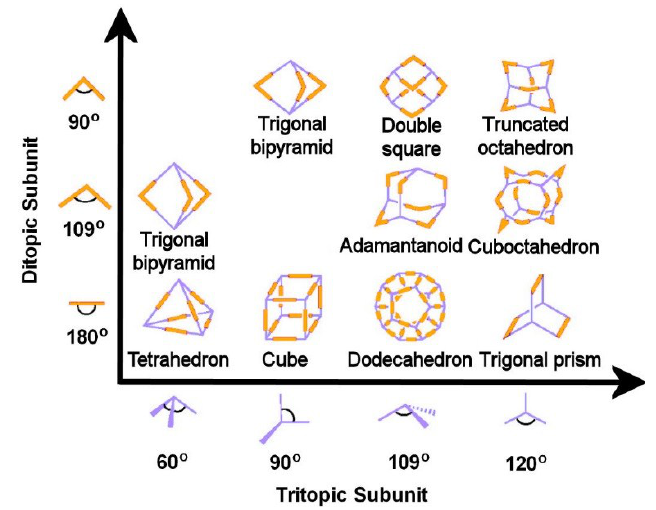
Figure 20. Formation of 3D architectures constructed by self-assembly of ditopic and tritopic building blocks. Adapted from Chem. Rev. 2011 , 111 , 6810–6918. Copyright (2011) Royal Society of Chemistry.